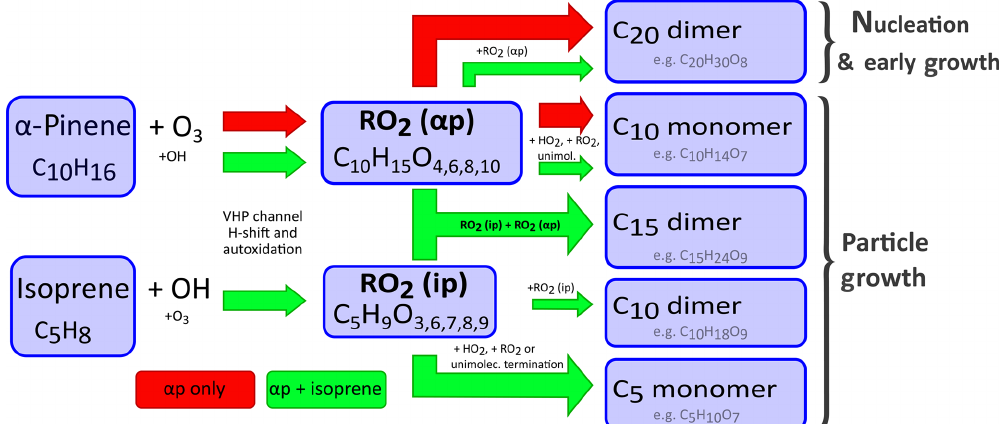
Figure 2. Proposed mechanism for the interference of isoprene in α -pinene oxidation chemistry. The pathway of HOM formation of an α -pinene–ozone mixture alone is indicated by red arrows. When isoprene is present, the green arrows indicate the additional interference of (cid:113) radicals. The oxidation of α -pinene in the conditions used in our experiments is dominated isoprene in α -pinene oxidation chemistry via RO 2 by ozonolysis. After the initial ozone attack a C 10 H 15 O 4 , peroxy radical forms via a vinylhydroperoxide channel (VHP), which can undergo various intramolecular H shifts and autoxidation steps. Thus the chain of RO 2 (α p ) mostly consists of C 10 H 15 O 4 , 6 , 8 , 10 . These radicals can (cid:113) terminate either via reaction with other RO 2 radicals, via reaction with HO 2 or via unimolecular processes. The resulting closed-shell products are then either covalently bound C 20 class dimers, which are mostly responsible for nucleation, or C 10 class monomers. Possible fragmentation might also lead to a low number of C 5 and C 15 class molecules being formed even without isoprene present. Isoprene oxidation (cid:113) (cid:113) is dominated by reactions with OH in the CLOUD chamber, which produce a series of C 5 RO 2 radicals (C 5 H 9 O 3 , 6 , 7 , 8 , 9 ). These RO 2 ( ip ) radicals can now interfere in the termination of RO 2 (α p ) . The reaction of RO 2 ( ip ) with RO 2 (α p ) can lead to C 15 class dimers, C 10 class monomers or C 5 class monomers. The reaction of RO 2 ( ip ) with another RO 2 ( ip ) can lead to C 10 class dimers or C 5 class monomers. The presence of RO 2 ( ip ) reduces the steady-state concentration of RO 2 (α p ) , as it acts as an additional sink for RO 2 (α p ) . This directly reduces the formation of C 20 class dimers, as two RO 2 (α p ) radicals are needed to form one C 20 class dimer. We link this reduction of C 20 class dimers to the reduction of biogenic nucleation and early growth rates in the presence of